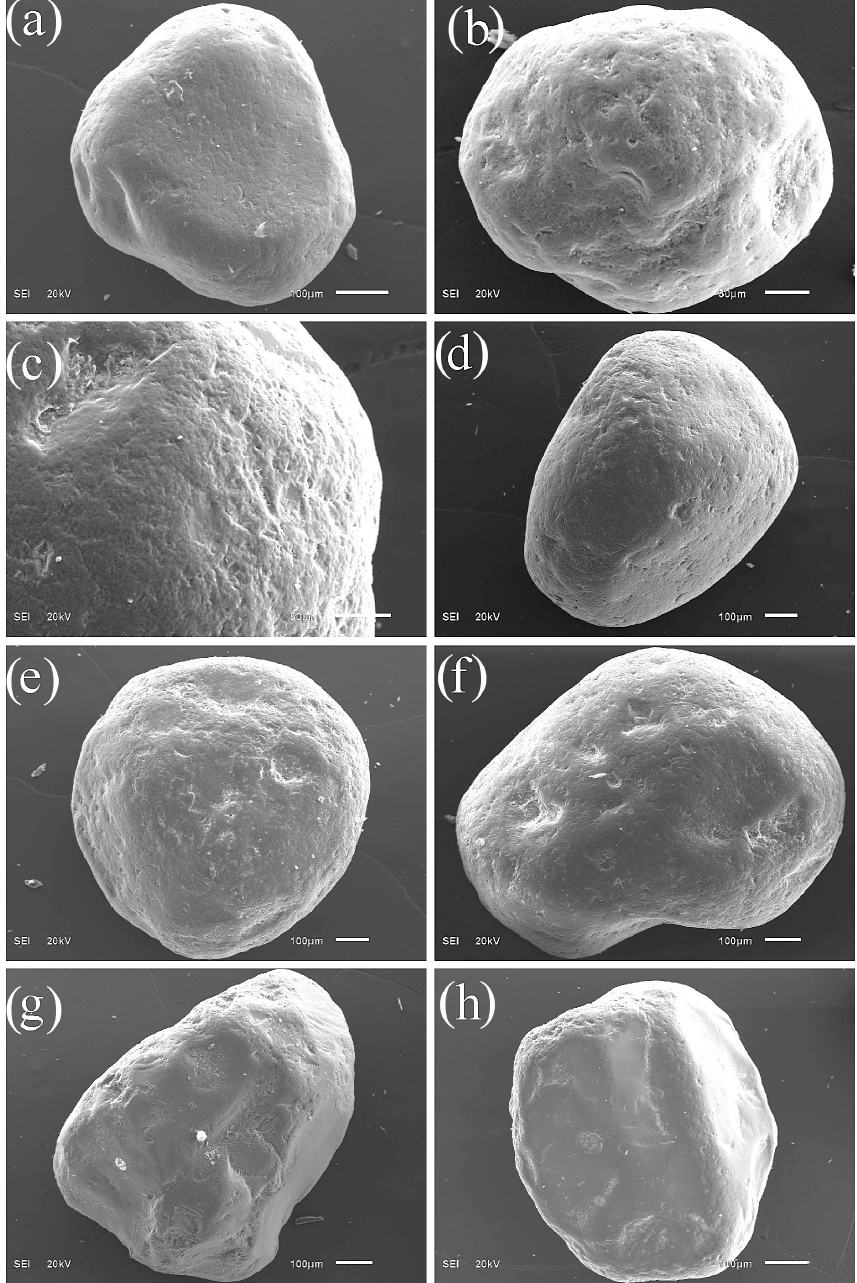
Figure A6. SEM photos of quartz grains, section NS-6. Aeolian sediments: (a) dull grain with a micro-pitted surface and individual crescent- shaped depressions; (b) matte grain with a micro-pitted surface and traces of previous subaquatic treatment. Floodplain sediments: (c) half- matte grain with V-shaped depressions, forming a fine-pitted surface, and with micro-pits; (d) half-matte grain with V-shaped depressions and fine pits. Fluvial deposits: (e) glossy grain with a fine-pitted surface; (f) half-matte grain with a fine-pitted surface and separate V-shaped depressions; (g) glossy grain with fine pits in the protruding parts of the grain; (h) glossy grain with pre-sedimentation fractures, with the surface subjected to aquatic processes, as expressed by the V-shaped